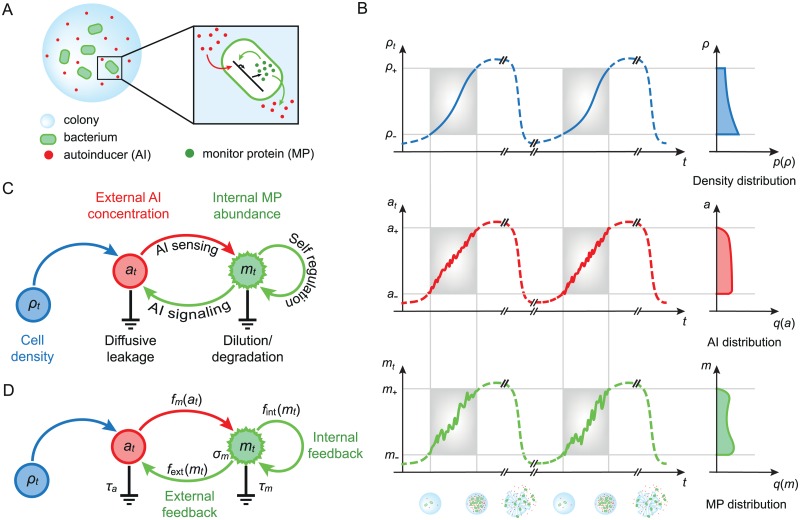
Signals, statistics, and dynamics in quorum sensing.
A. A growing bacterial colony tracks the concentration of endogenously produced autoinducers (AIs) via the internal abundance of a monitor protein (MP). B. The quorum-sensing system responds to changing cell density ρ by regulating the concentration of external autoinducers a
t and the internal concentration of MPs m
t. A succession of identical growth cycles yields stationary distributions for ρ, a, and m within the operational range of quorum sensing (shaded frames). C. Dependency graph modeling quorum sensing with feedback from MP expression to AI signaling and to AI sensing. D. Functions parametrizing the stochastic dynamics of the quorum-sensing response. The AI output rate f
ext and the self-regulation level f
int are emphasized as the external and internal feedback, respectively.